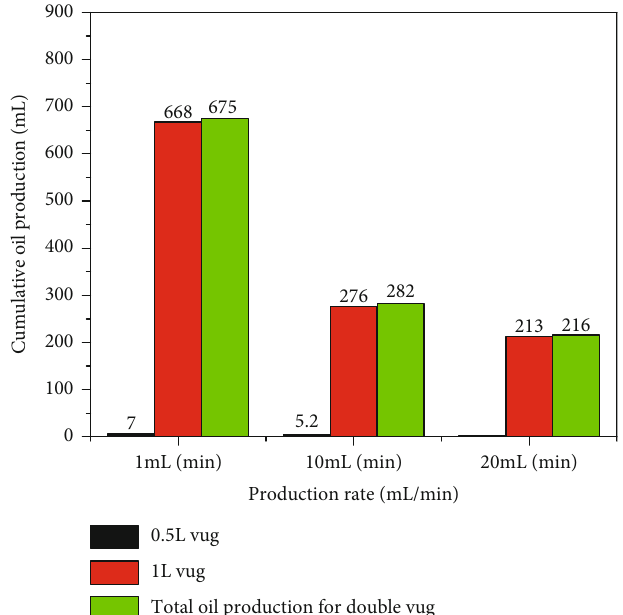
Figure 14: Column chart of cumulative oil production in high-pressure physical property experiments under connection type I (di ff erent production rates).